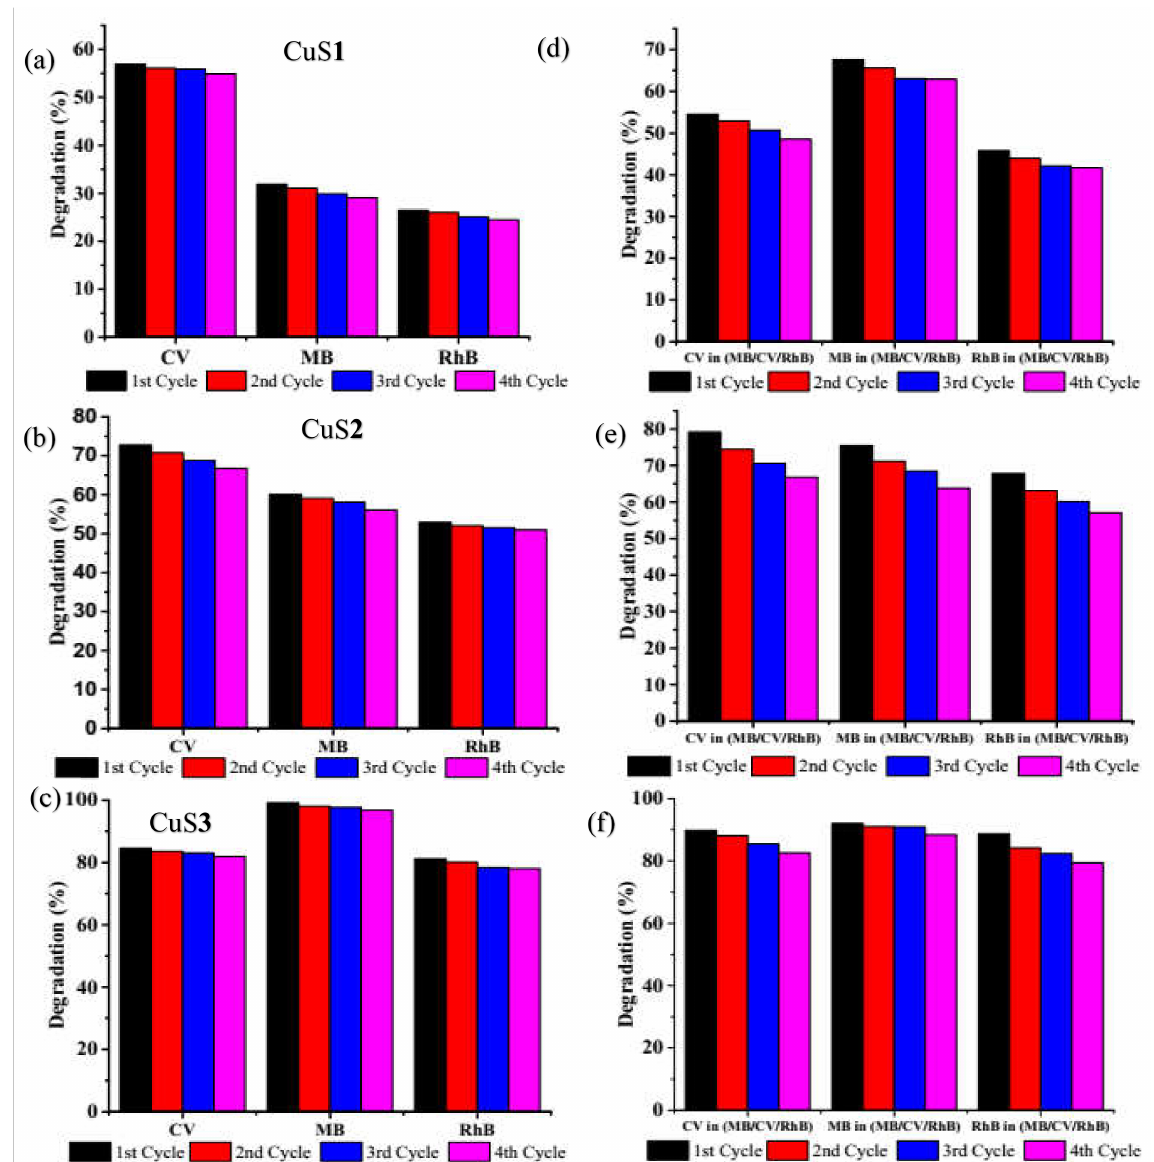
Figure 9. Degradation of crystal violet, methylene blue, and rhodamine B ( a – c ) and ternary dyes ( d – f ) cycle runs by CuS nanoparticles under visible light